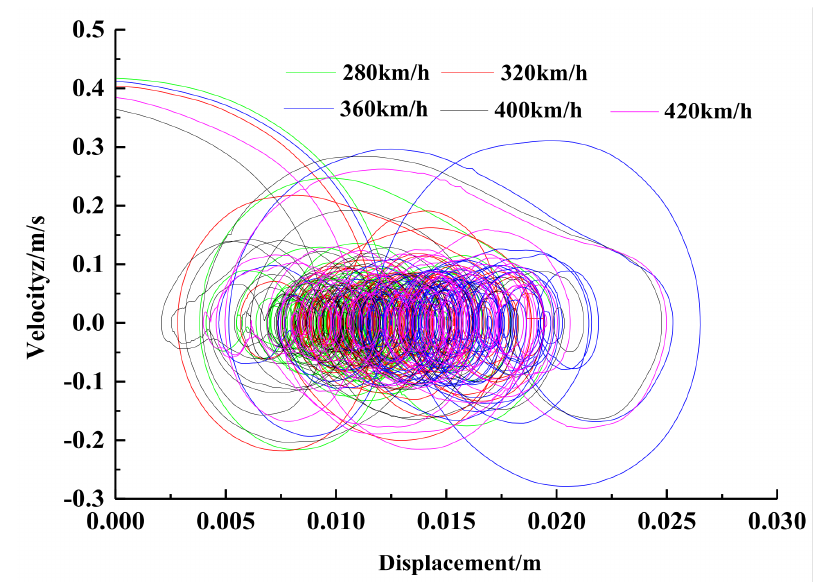
Figure 18. Phase diagram of contact strip passing through a tunnel at different